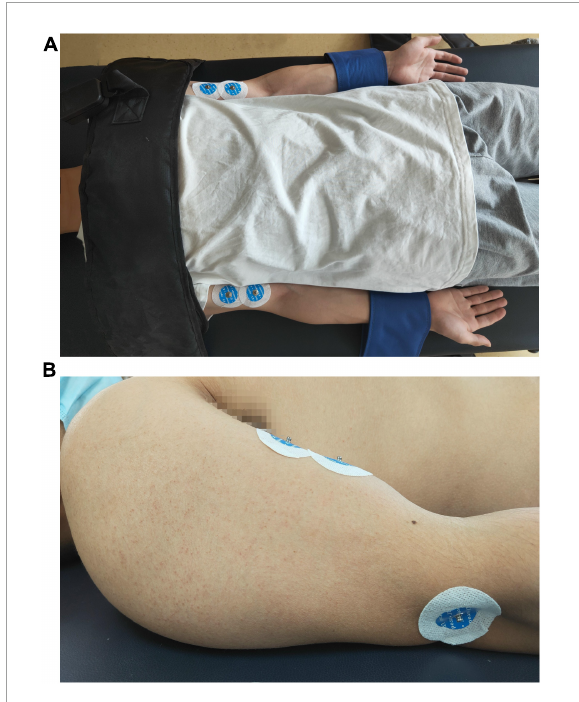
FIGURE1 Positions of the surface electromyography electrodes. (A) A photo of a volunteer to show the position of the body, the fixation belts and the location of the electrodes on bilateral upper extremities. (B) A photo of a volunteer to show the lateral side of the location of the electrodes on upper extremity.